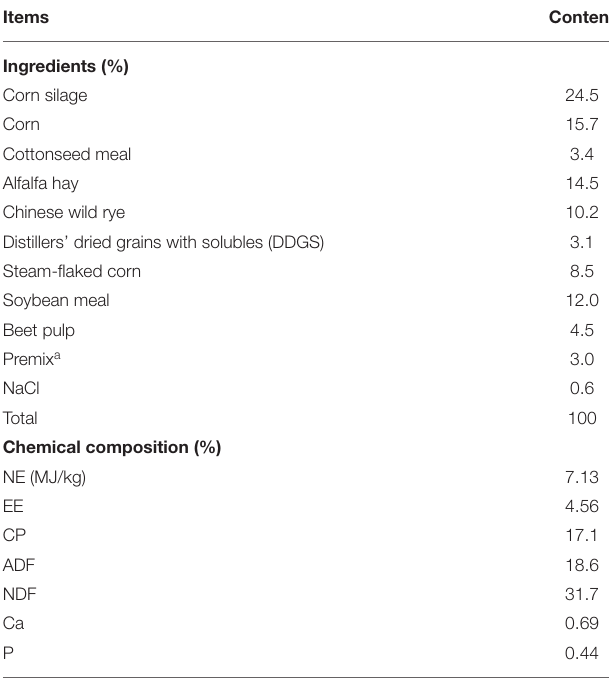
TABLE 1 | Ingredients and chemical composition of the TMR (dry-matter